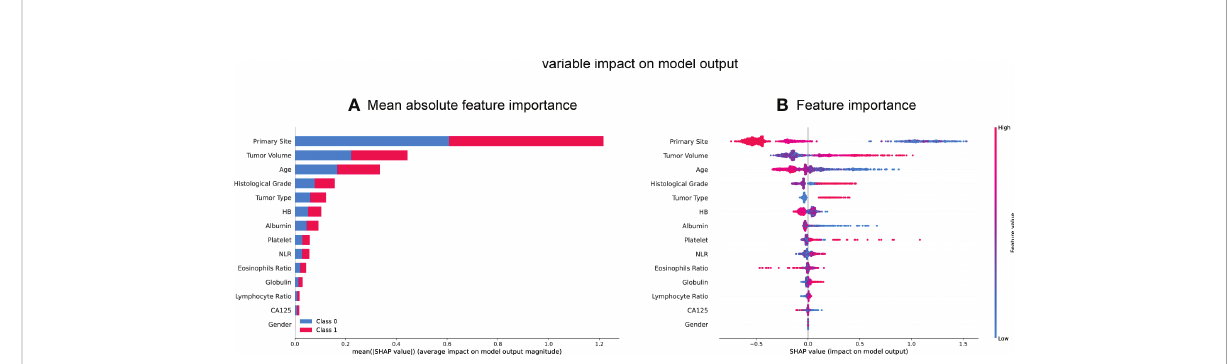
FIGURE 2 SHAP summary plot of the 14 feature of the stacking model. (A, B) Each dot corresponds to each feature attribution value for the model of each patient, with positive values indicating a contribution that increase the probability of dMMR development while negative values indicating a contribution that decreases the probability. Dots are colored according to the values of features for the respective patient and accumulate vertically to depict density. Red represents higher feature values, and blue respective lower feature values. HB, hemoglobin; NLR, neutral lymphoid ratio; CA125, carbohydrate antigen